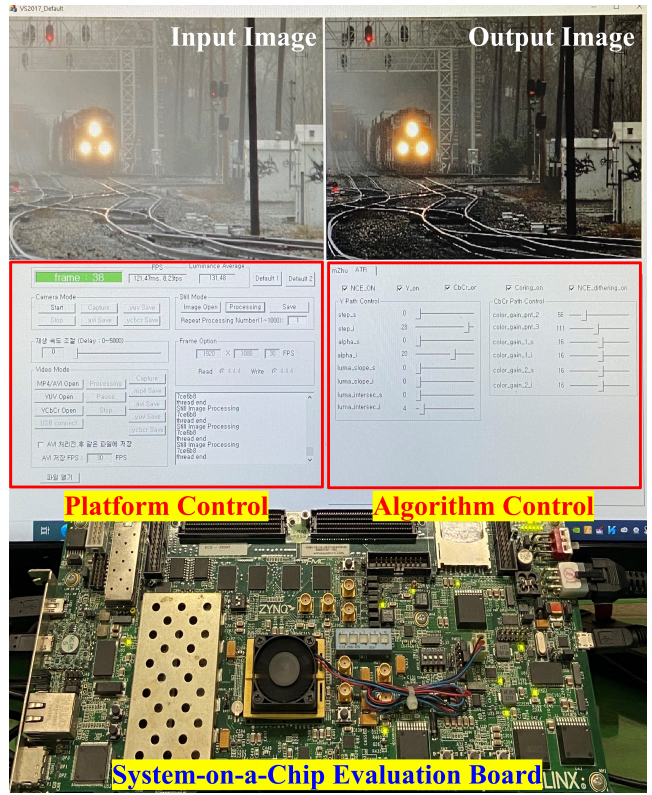
Figure 18. Hardware verification using a system-on-a-chip evaluation